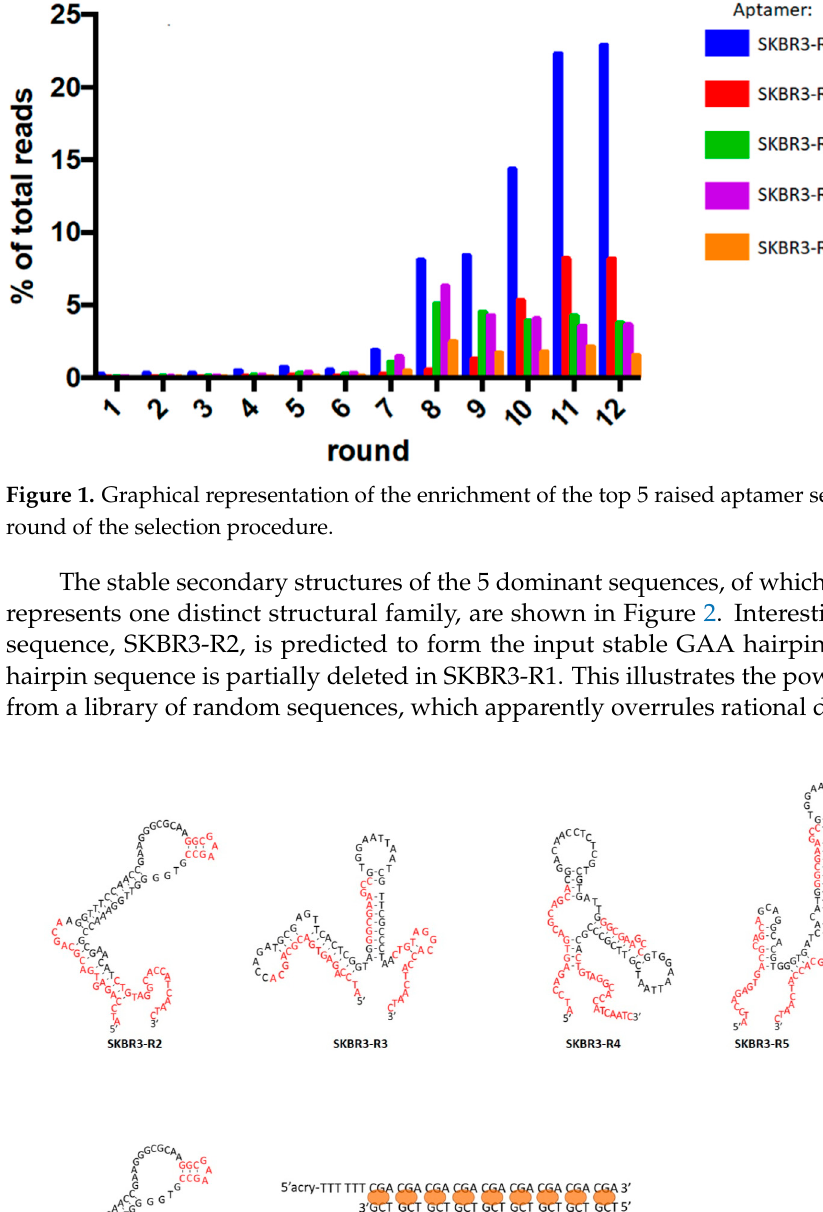
Figure 2. ( A ) Predicted secondary structures of the top 5 raised aptamers. Structures were obtained with the DNA folding module on the Mfold webserver [14] using ionic strength conditions of 150 mM NaCl and 5 mM Mg 2+ at 20 ◦ C. Nucleotides